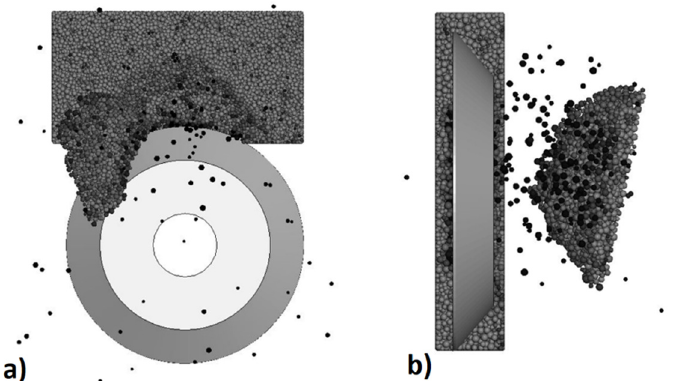
Figure 7. The results of the simulation test of concrete sample mining by asymmetrical mini-disk tool of diameter d = 160 mm and mining spacing t = 25 mm: ( a ) side view, ( b ) top view .